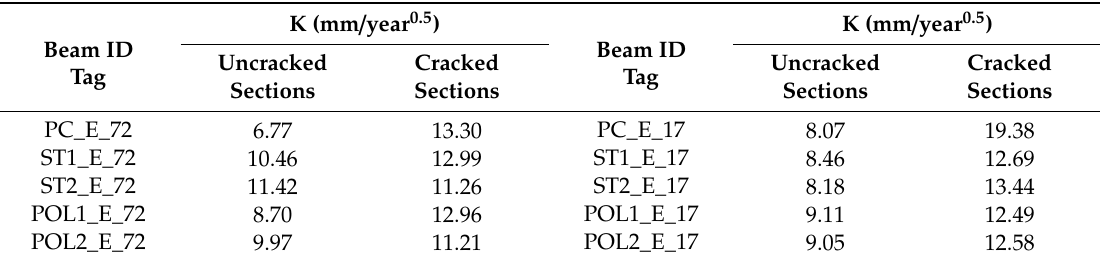
Table 5. Carbonation coe ffi cients in exposed beams: 17 vs. 72 months.